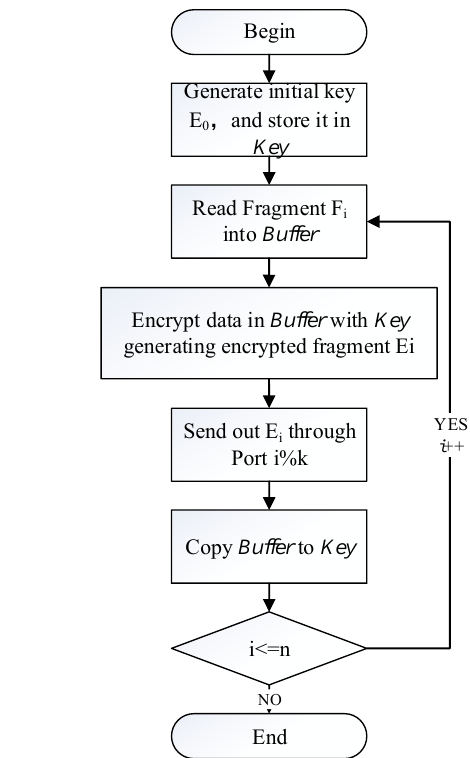
Figure 6. Flow Diagram of Data Encrypted and Sent